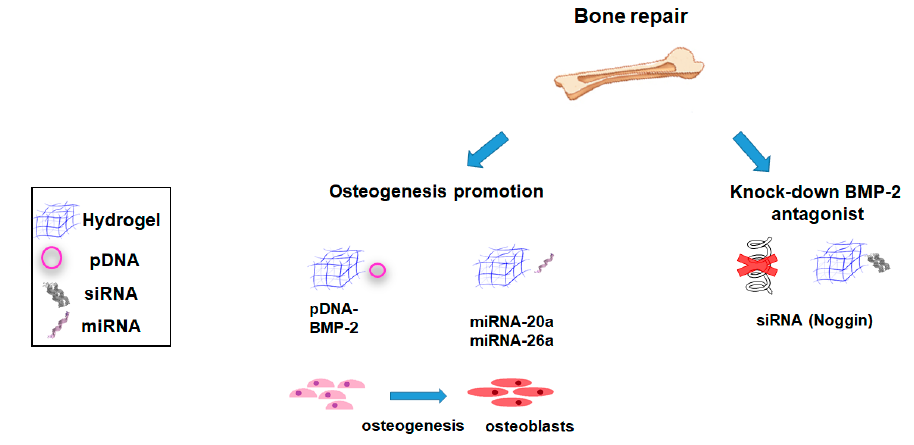
Figure 1. Main strategies involving the use of hydrogel-based nonviral gene delivery systems for bone tissue repair.